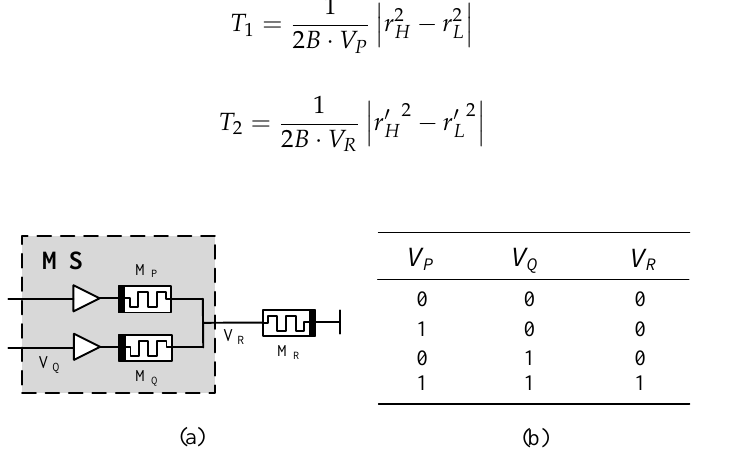
Figure 4. Logic switch based on spin memristor. ( a ) Logical switch based on memristor. ( b ) Truth table for AND